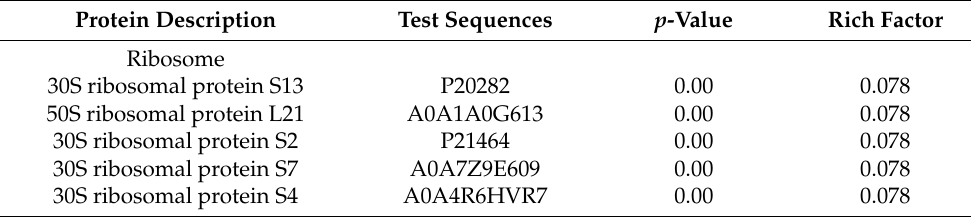
Table 3. The respective DEPs in B. subtilis spores against LK treatment. Protein